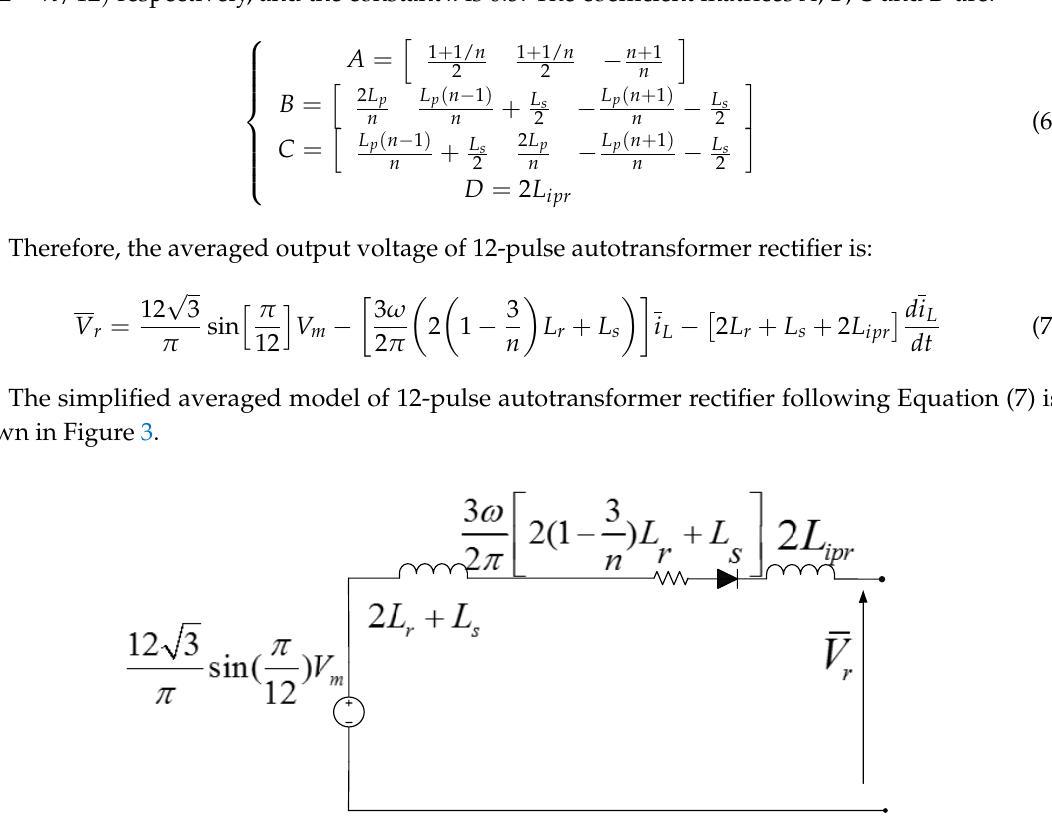
Figure 3. Average value model of 12-pulse autotransformer.